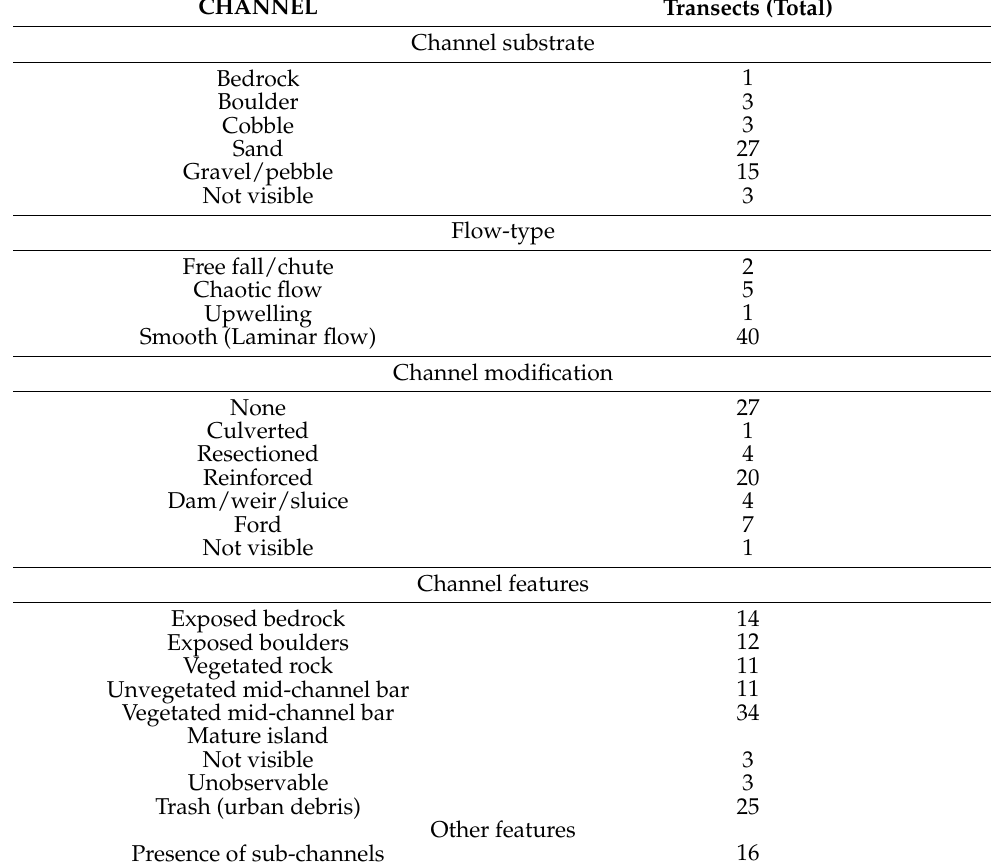
Table 3. Representativeness of observations in Section E for the channel.